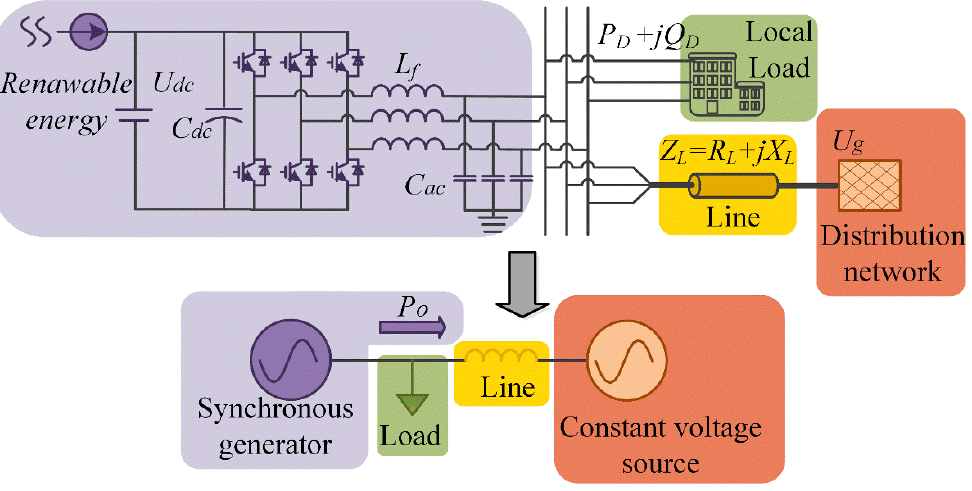
Figure 2. Synchronous generator model.